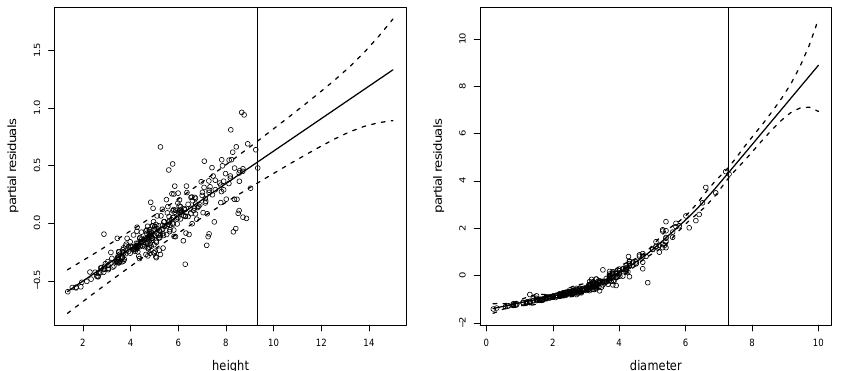
Figure 5. Fitted and predicted smooth curves for height ( left ) and for diameter ( right ) using the restricted S-ANOVA model. The vertical line indicates the height and diameter values from which we predict (9.32 and 7.3).